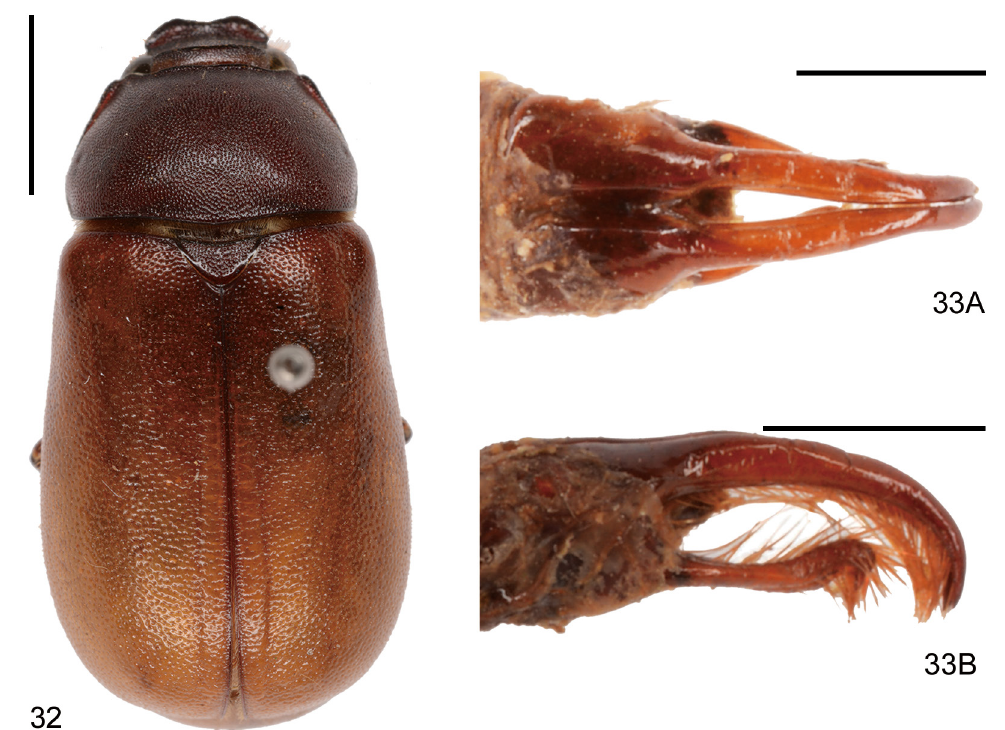
Figs 32–33. Miridiba excisa (Moser, 1913), paralectotype (1721 BMNH). 32 . Habitus in dorsal view. 33 . Parameres in dorsal (A) and lateral (B) views. Scale bars: 32 = 5.0 mm; 33 = 1.0